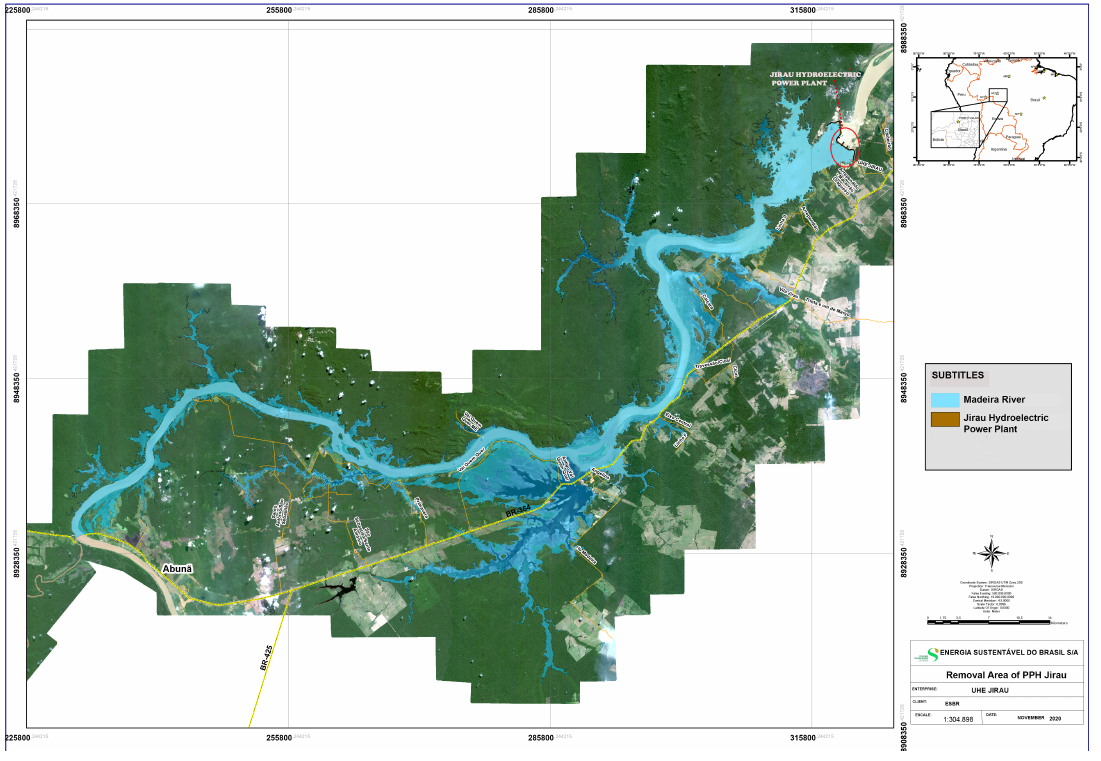
Figure 1. Madeira river